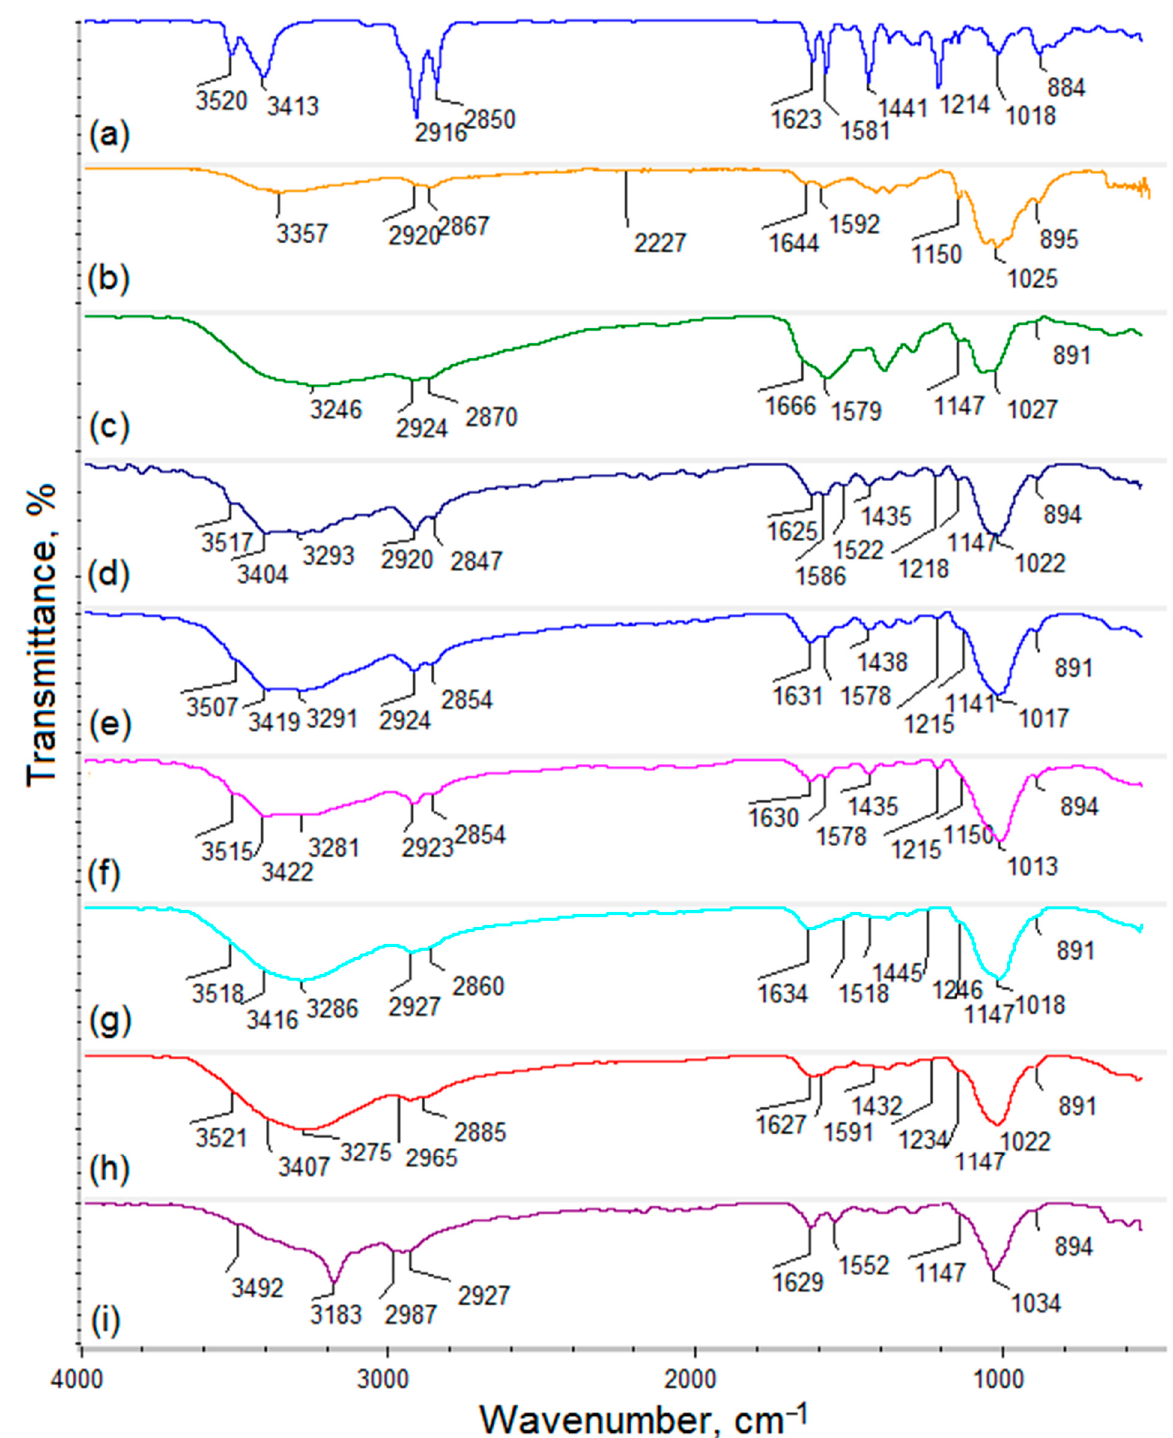
Figure 2. FT-IR spectra:( a ) cannabidiol; ( b ) pure chitosan; ( c ) chitosan crosslinked with L-aspartic and L-glutamic acid; ( d ) CS-ZnO-1; ( e ) CS-ZnO-2; ( f ) CS-ZnO-3; ( g ) CS-ZnO-4; ( h ) CS-ZnO-5; and ( i ) CS-ZnO-6 .